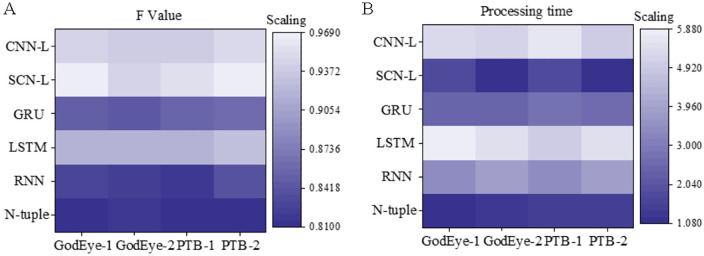
Evaluation of machine translation model of neural network based on residual and LSTM in F value and processing time.